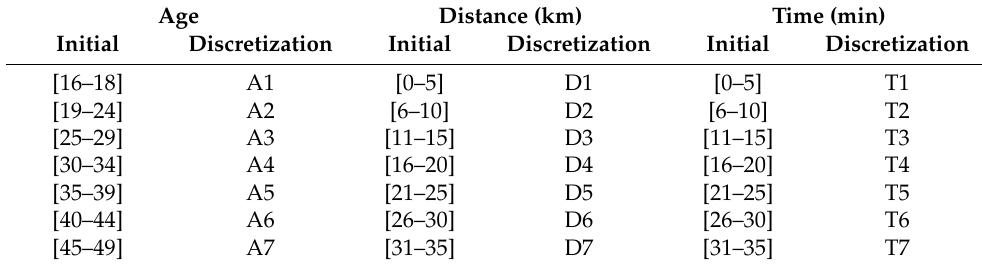
Table 2. Variable